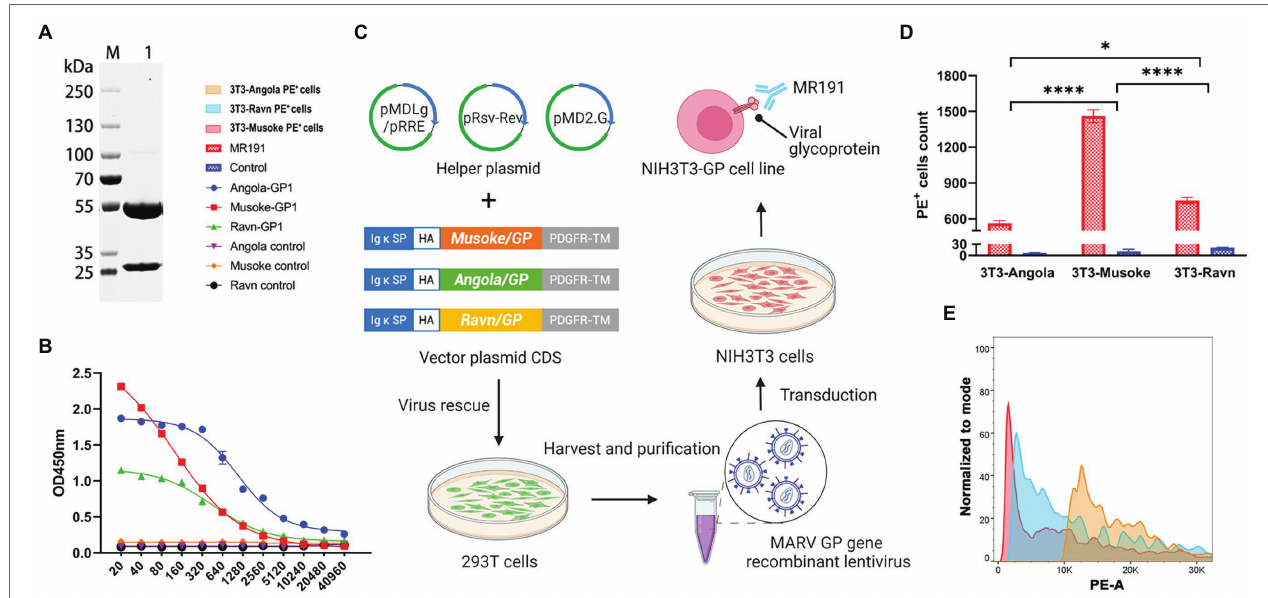
FIGURE 1 | Binding activity of neutralizing antibody MR191 (A) SDS-PAGE identification of MR191. The reduced MR191 was identified using a 4–20% SDS-PAGE gel. The light chain can be detected at 25 kDa and the heavy chain at 55 kDa. (B) ELISA compared the binding ability of MR191 to GP1 of each strain. (C) Construction process of MARV GP-expressing 3 T3 cell line. Murine Ig κ -chain leader sequence and HA sequence replace the original signal peptide of MARV GP. The original transmembrane domain was replaced by a Platelet-derived growth factor receptor transmembrane domain sequence to complete the mammalian cell display of GP. The engineered MARV GP was transduced by lentivirus to obtain cell lines. (D) Validation of the binding ability of MR191 to GP using cell lines. Under the premise of considering the influence of the control group, the number of PE cells in each group of cell lines combined with MR191 was used as an indicator for 2way ANOVA analysis to compare the differences in GP binding between MR191 different strains in vitro . The 3 T3-Musoke group was significantly higher than the other two groups ( p < 0.0001). 3 T3-Ravn was higher than 3 T3-Angola ( p = 0.0229). (E) PE + signal in flow cytometry analysis after MR191 binding to three cell